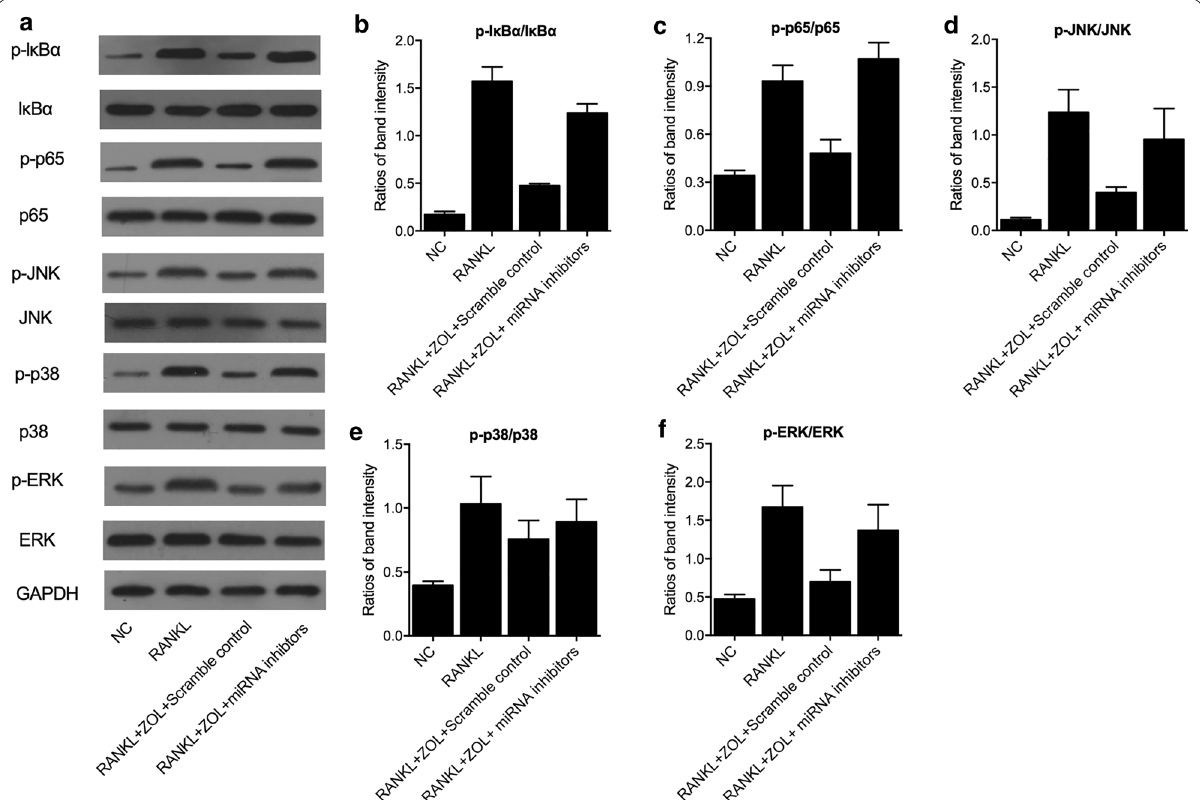
Fig. 7 RANKL‑induced activation of NF‑κB and JNK signaling pathways was attenuated by ZOL treatment in human osteoclast precursor cells (*P value < 0.05 vs. NC group; #P value < 0.05 vs. RANKL group; ^P value < 0.05 vs. RANKL ZOL Scramble control group). a Western blot + + analysis showed ZOL treatment restored the normal expression of genes related to NF‑κB and JNK signaling pathways, while the knockdown of miR‑302, miR‑101 and miR‑145 reversed this situation. b Quantitative analysis of Western blot showed that RANKL induced‑upregulation of p‑lκBα/lκBα expression was suppressed by ZOL treatment, while the knockdown of miR‑302, miR‑101 and miR‑145 reversed this situation. c Quantitative analysis of Western blot showed that RANKL induced‑upregulation of p‑p65/p65 expression was suppressed by ZOL treatment, while the knockdown of miR‑302, miR‑101 and miR‑145 reversed this situation. d Quantitative analysis of Western blot showed that RANKL induced‑upregulation of p‑JNK/JNK expression was suppressed by ZOL treatment, while the knockdown of miR‑302, miR‑101 and miR‑145 reversed this situation. e Quantitative analysis of Western blot showed that RANKL induced‑upregulation of p‑p38/p38 expression was suppressed by ZOL treatment, while the knockdown of miR‑302, miR‑101 and miR‑145 reversed this situation. f Quantitative analysis of Western blot showed that RANKL induced‑upregulation of p‑ERK/ERK expression was suppressed by ZOL treatment, while the knockdown of miR‑302, miR‑101 and miR‑145 reversed this